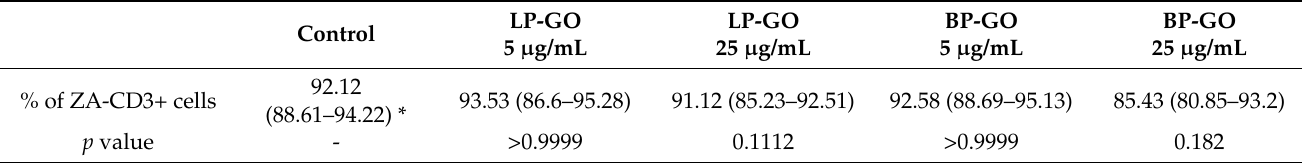
Table 2. Viability of lymphocytes in cultures with P-GO